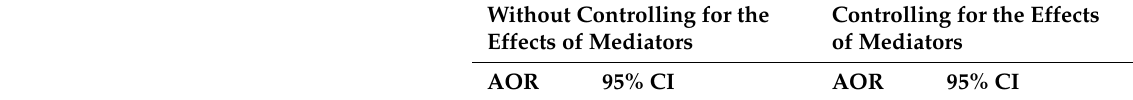
Controlling for the Effects of